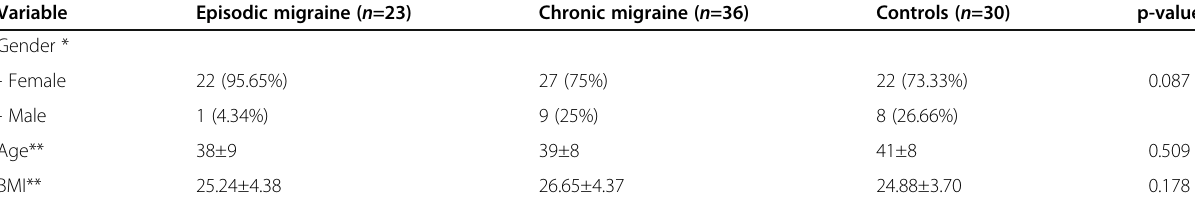
Table 1 Demographics and baseline characteristics of patients